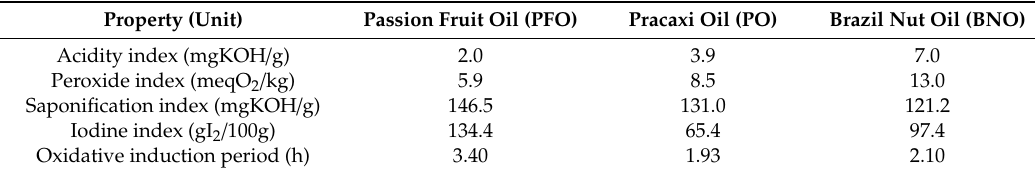
Table 2. Physicochemical characterization of reference vegetable